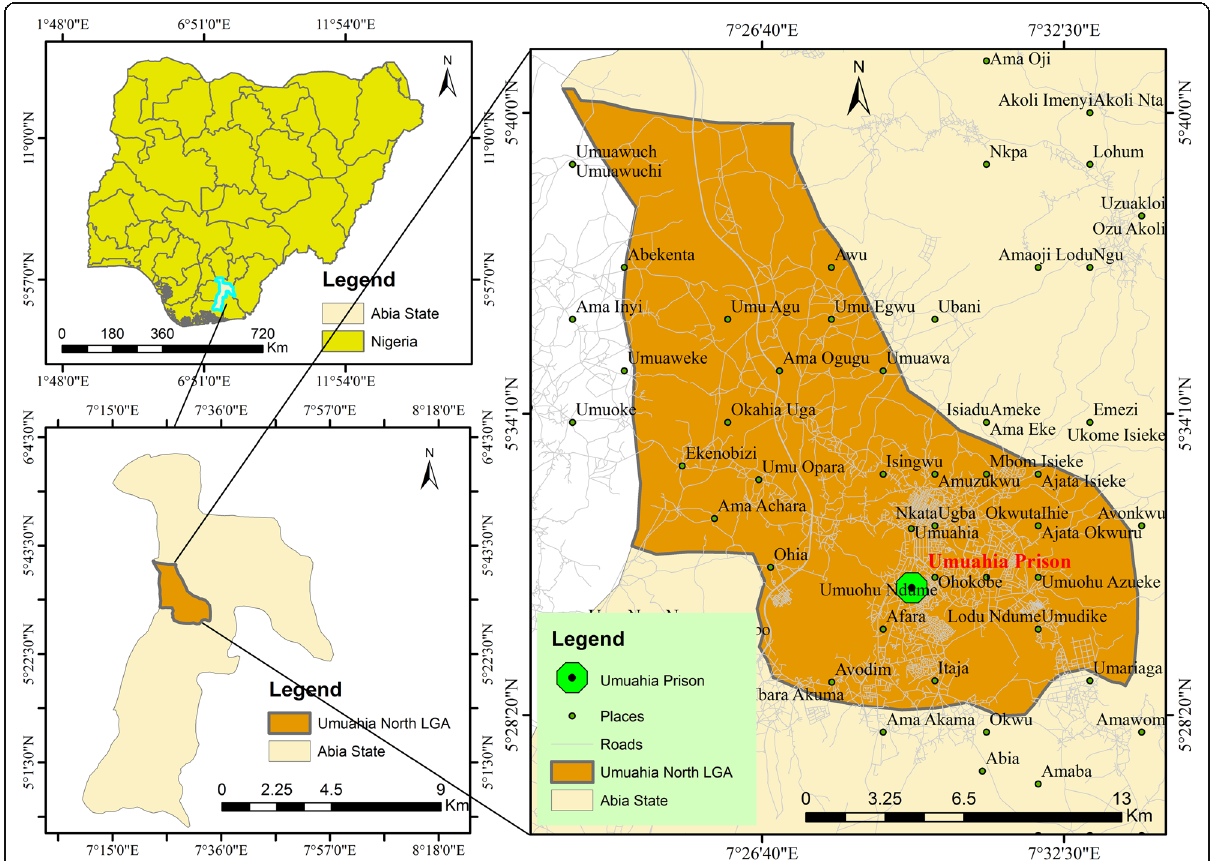
Fig. 1 Map of Umuahia showing the location of the Prison, Aba Road,